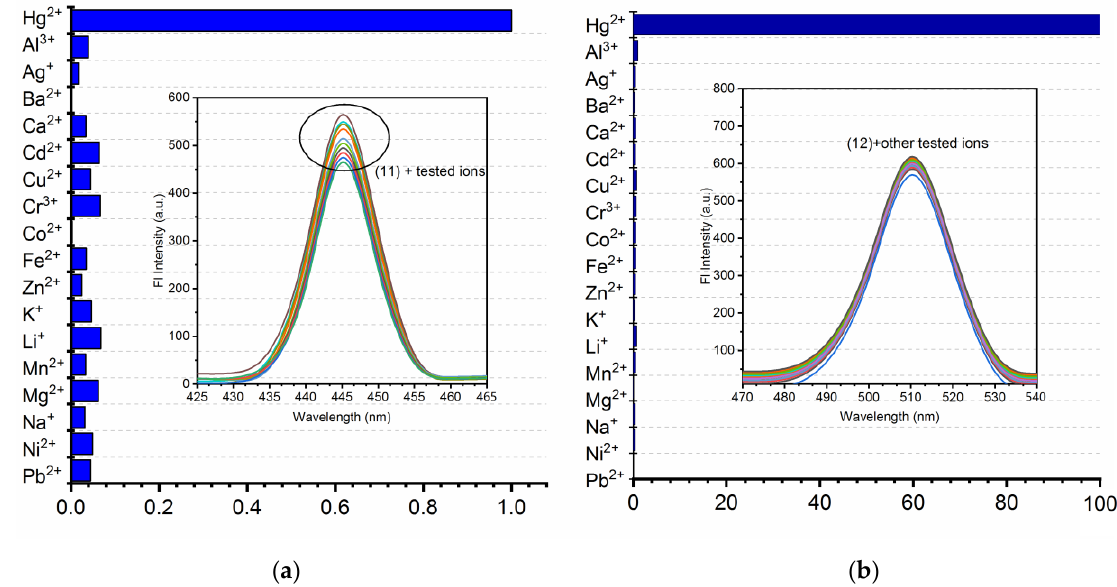
Figure 6. Normalized plots of nano-composites ( a ) → (11) ; ( b ) → (12) in the presence of various tested metal ions; inset emission spectra of nano-composites ( a ) → (11) ; ( b ) → (12) with different tested ions.